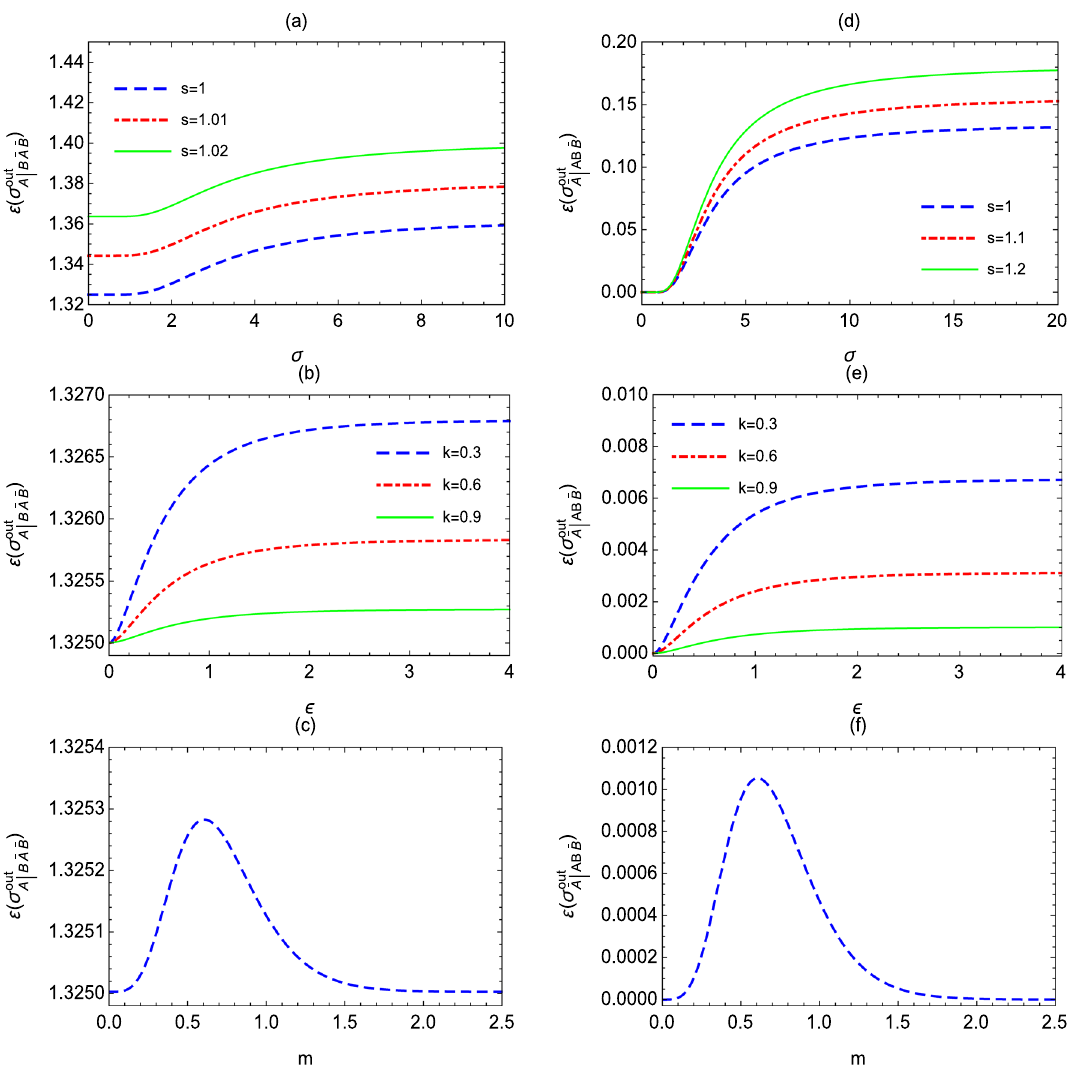
Fig. 3 1 → 3 entanglement a and d as a function of the expansion rate σ for different squeezing parameters s . 1 → 3 entanglement b and e as a function of the expansion volume (cid:9) for different momentums k . 1 → 3 entanglement c and f as a function of the mass m . The other parameters are set to 1 (cid:9) influence the residual entanglement E res (σ out ) . AB ¯ A ¯ B